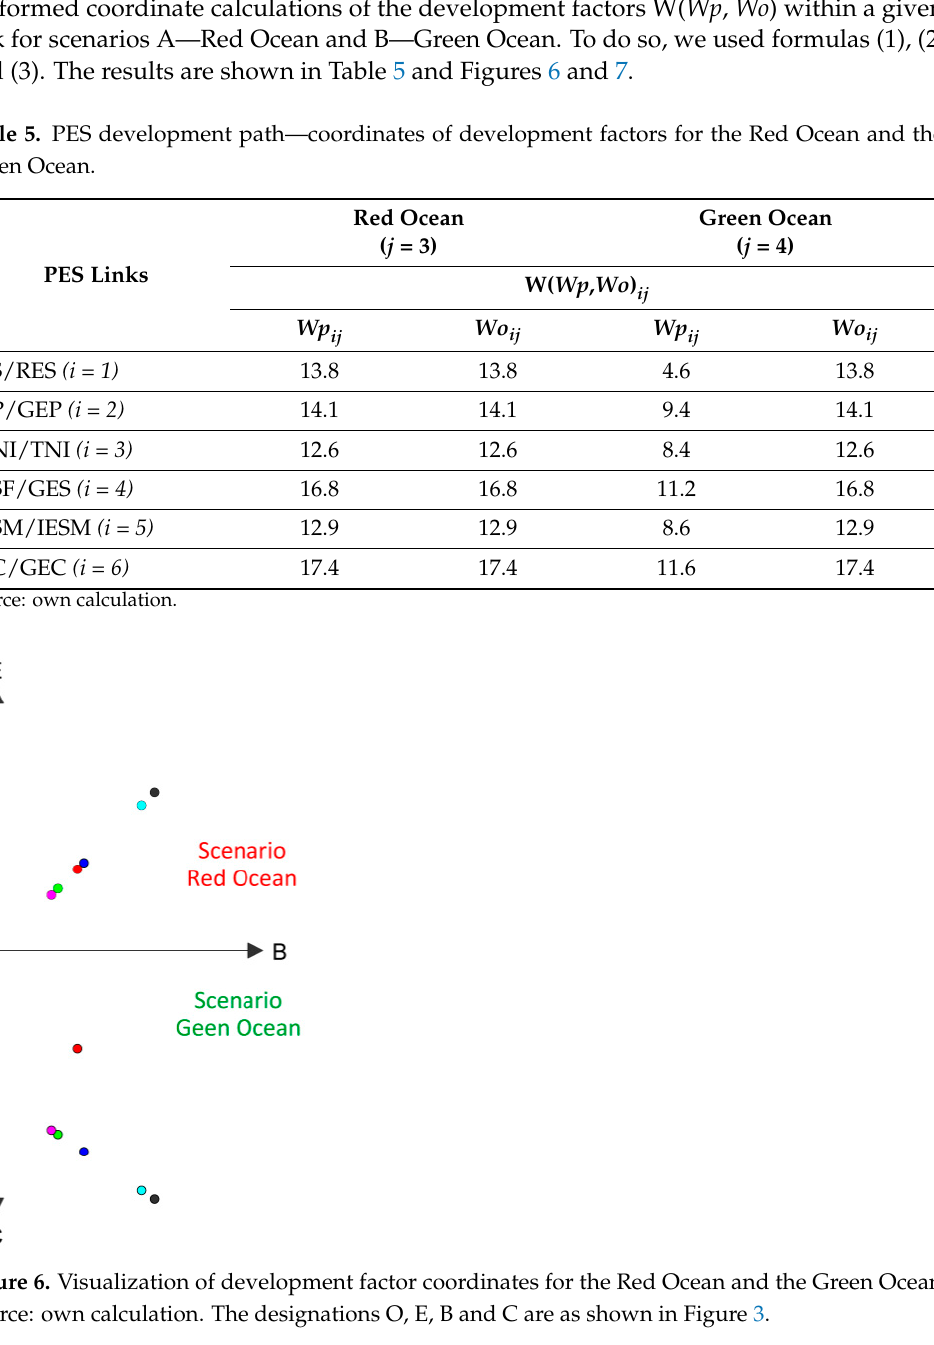
Figure 7. Visualization of development paths: vector OA and vector OF. Source: own calculation. The designations O, E, A, B, F and C are as shown in Figure 3. Analysis of the data in Table 5 and Figure 6 indicates that at the time the analyses were performed, the development factors W (Wp , Wo ) for a given link under scenario A— Red Ocean, balanced each other out. That is, it is not possible to indicate whether the dominant share is held by the state or the community sector. In this case, the coordinates of the development factors W (Wp , Wo ) are distributed along a straight line and do not form a separate area. The coordinate of the characteristic point of the OA vector was cal- culated using the mean value of Wp and Wo coordinates. For the development factors W (Wp , Wo ) for a given link under scenario B—Green Ocean, asymmetry was observed for the community factors (Figure 7). Community